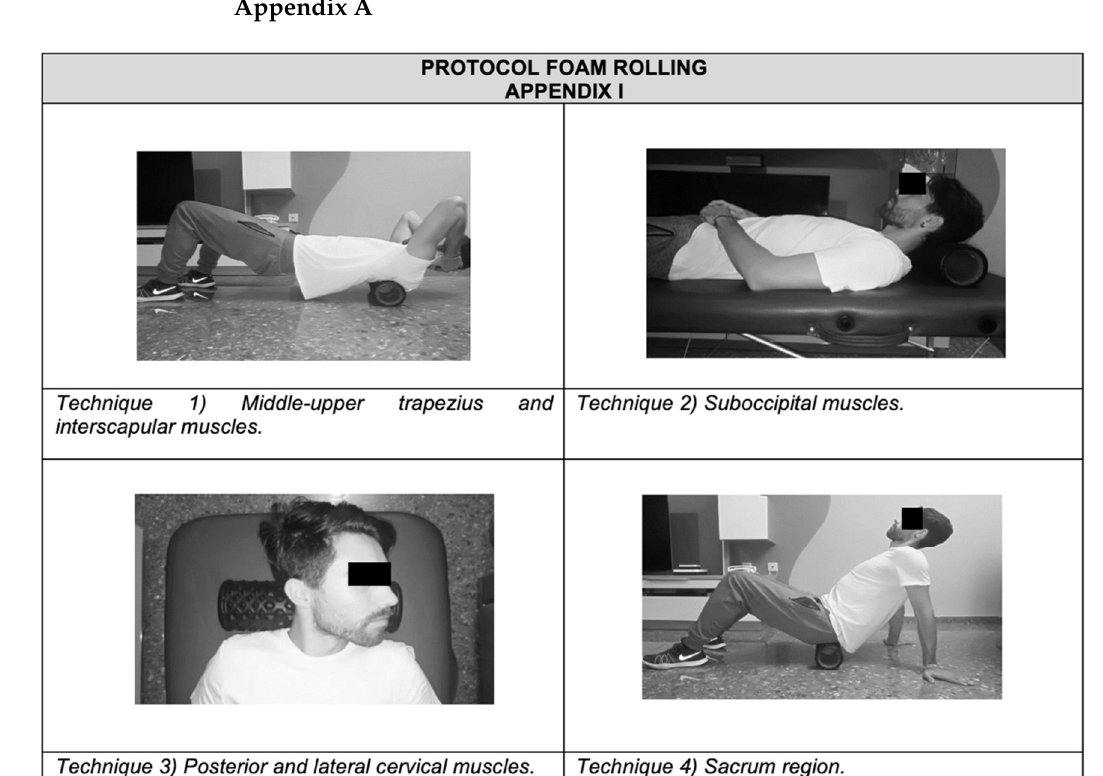
Figure A1. Protocol treatment with foam rolling.